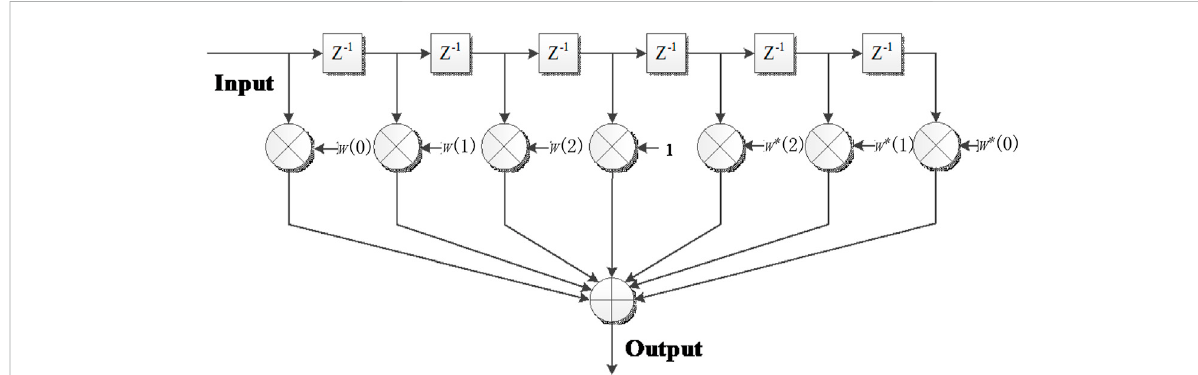
FIGURE 3 The architecture of the time-domain anti-jamming fi lter.